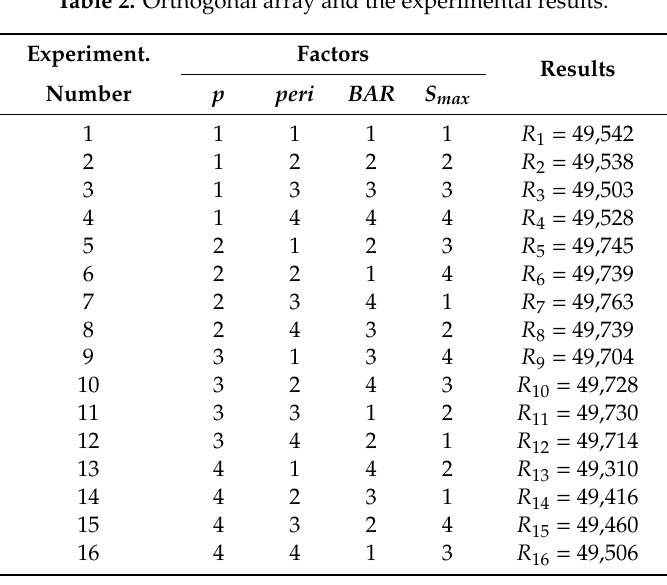
Table 2. Orthogonal array and the experimental